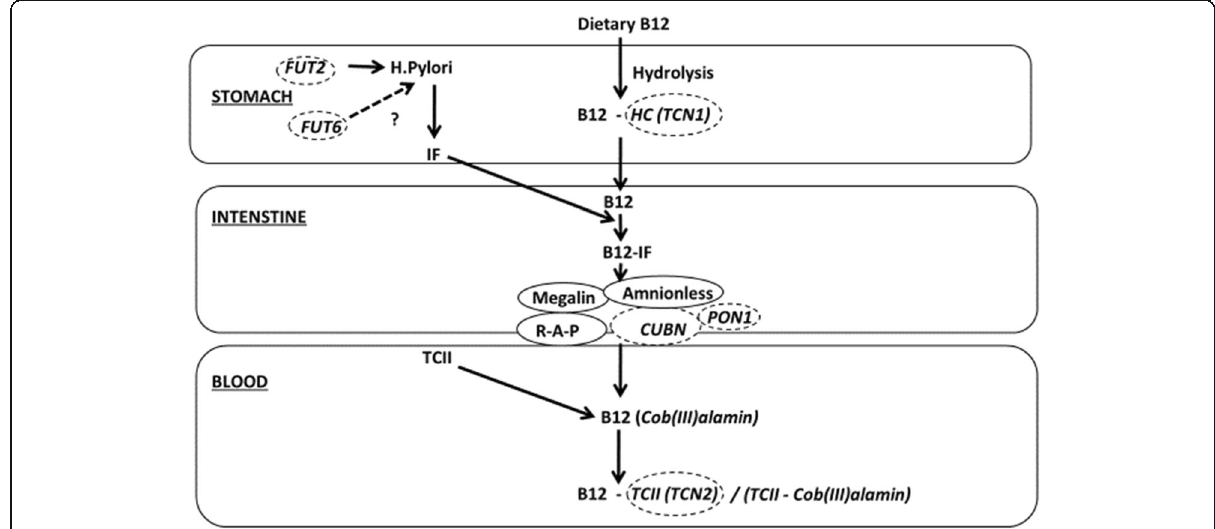
Fig. 2 Diagram representing the genes associated with vitamin B12 status. The diagram shows the proteins involved in the metabolism of vitamin B12 from dietary intake to reaching the circulatory system. Genes identified to harbour variants regulating serum levels of B12 are surrounded by dashed lines. B12 vitamin B12, CUBN cubilin (intrinsic factor-cobalamin receptor), FUT2 fucosyl-transferase 2, FUT6 fucosyl-transferase 6, HC haptocorrin (TCN1), H. pylori Helicobacter pylori , IF intrinsic factor, PON1 serum paraoxonase/arylesterase 1, R-A-P receptor-associated-protein, TCII transcobalamin II (TCN2), TCII-R transcobalamin II receptor